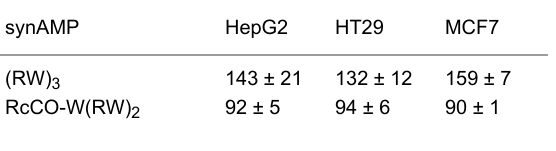
Table 5: IC 50 values (in µM) of both (RW) 3 and RcCO-W(RW) 2 against human liver carcinoma (HepG2), human colon cancer (HT29) and human breast cancer (MCF7) cell